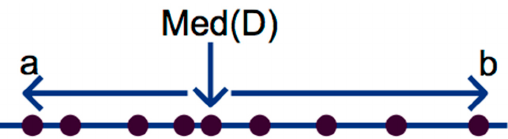
Figure 5. Intervals a and b are optimized from available experimental data for the formation of said information granule, where both lengths start at the median of the information granule’s experimental